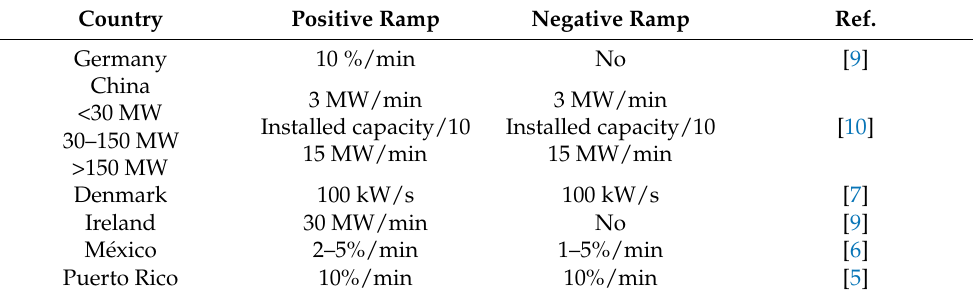
Table 1. Maximum power ramp-rate requirements ( r max ) for different countries. Country Positive